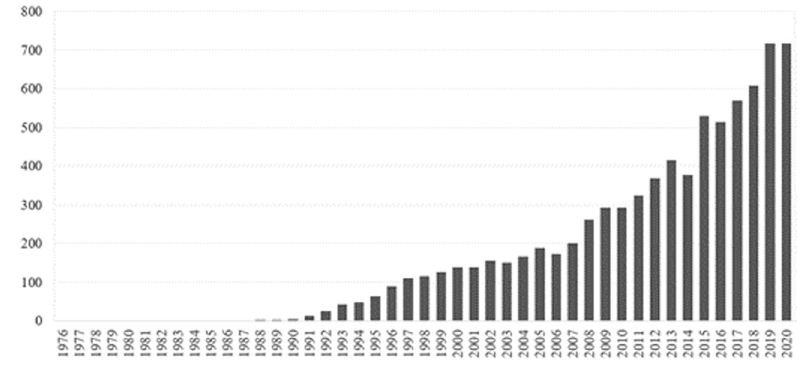
Fig. 2 Publications by year. Source: Web of Science, 2021.